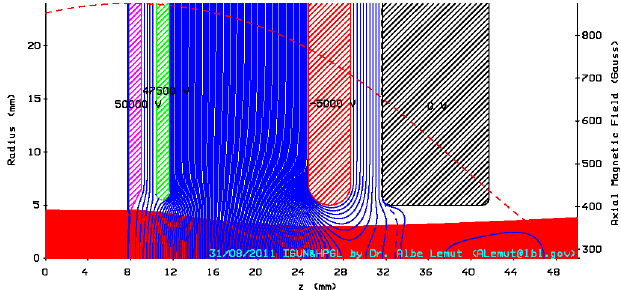
FIG. 2. Calculation of the extraction of 4 He þ 50 mA by means of the IGUN program [16]. The extraction electrode (shaded magenta area, inner radius 4.5 mm), the puller electrode (shaded green area), screening electrode (shaded red area), ground elec- trode (shaded black area), particle trajectories (red), and equi- potential lines (blue) for a 50 kV extraction voltage are shown. The final ( z ¼ 50 mm ) beam emittance (cid:3) 4 rms is 4 (cid:2) mm mrad , the radius 3.9 mm, and the divergence 55.1 mrad. The axial magnetic field (dashed red line), and the (cid:1) 200 V equipotential (dashed blue lines) are also plotted (see text in Sec. III